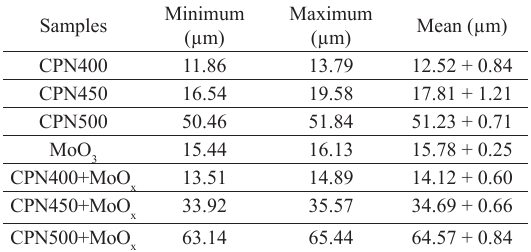
Table 2. Minimum, maximum and mean thickness values from the coatings. Each mean corresponds to the average of 5 different measurements.